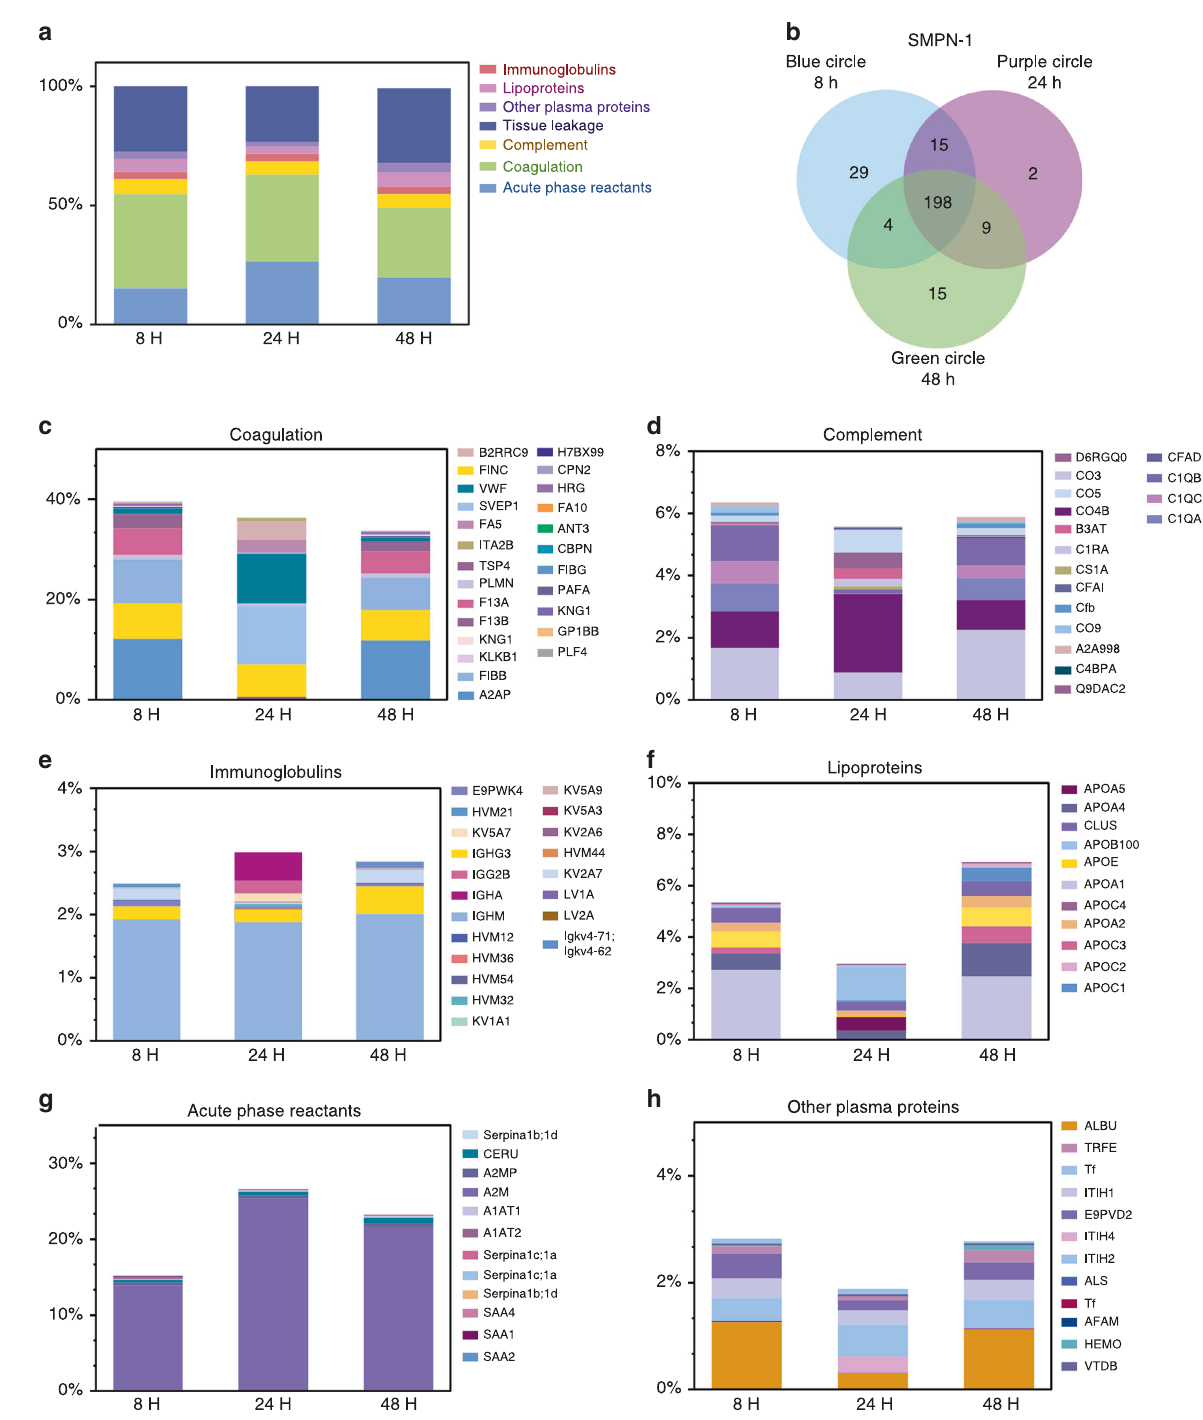
Fig. 3 Analysis of protein corona formed at the nano-biointerface of SMPN-1. Proteins identi fi ed on SMPN-1 at 8, 24, and 48 h post i.v. injection in mice ( n = 4) were classi fi ed based on its biological function. a Abundance of each functional protein group as the percentage of total proteins on SMPN-1 shown at each time point. b The unique and common proteins between 8, 24, and 48 h time on SMPN-1 depicted as a Venn diagram. The number of proteins is shown here is an additive combination of four independent biological analyses with three technical replicates for each biological sample. Abundance of proteins classi fi ed based on their biological activity on the corona of SMPN-1 c coagulation proteins, d complement proteins, e immunoglobulins, f lipoproteins, g acute phase reactants, and h other plasma